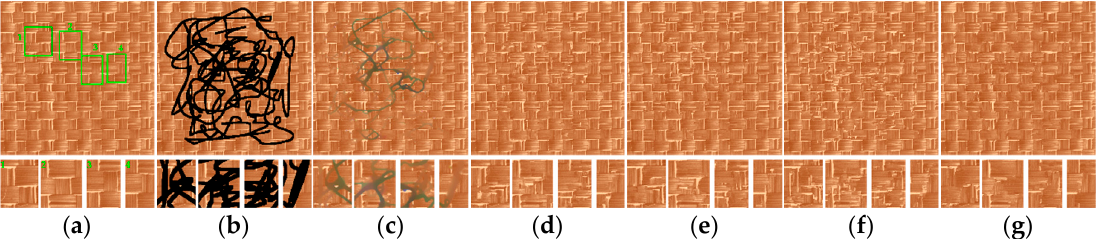
Figure 11. Comparison of inpainting results for regular pattern Texture II (640 × 640): ( a ) Ground truth; ( b ) incomplete image; ( c ) CDD model [4]; ( d ) Criminisi’s method [10]; ( e ) Liu’s method [17]; ( f ) Zhou’s method [18]; ( g ) proposed method.